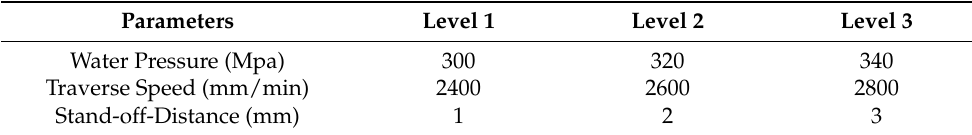
Table 4. Input parameters levels for specimen thickness of 2 mm, in the abrasive waterjet cutting process.